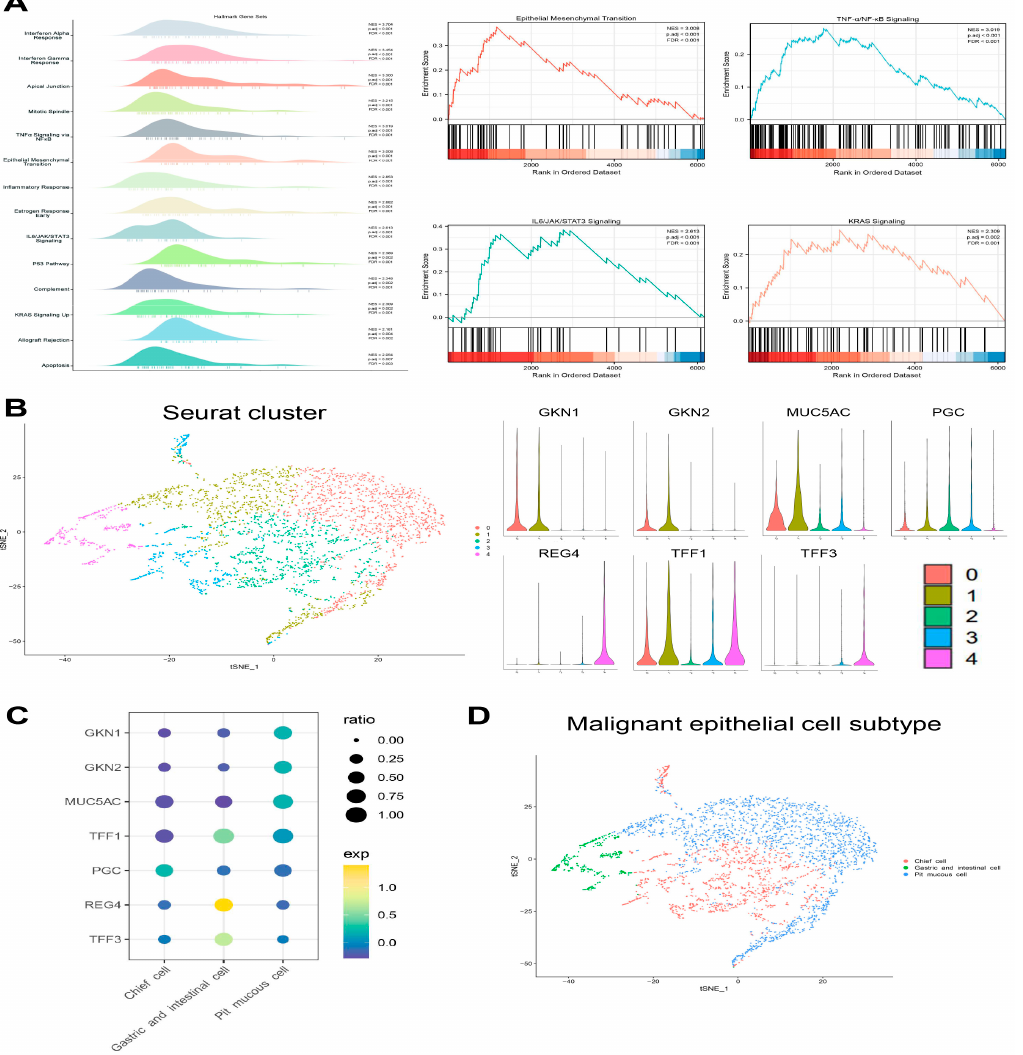
Figure 5. Cellular atlas of the malignant epithelial cell subtypes. ( A ) The GSEA results show the enrichment gene sets in malignant epithelial cells, and four of them were GC-associated gene sets. ( B ) tSNE plot showing the malignant epithelial cells seurat cluster, and Violin plots showing the expression distribution of subtype marker genes in five clusters. ( C ) Bubble plot showing the expression levels of marker genes in three subtypes. ( D ) tSNE plot showing the subtypes for malignant epithelial